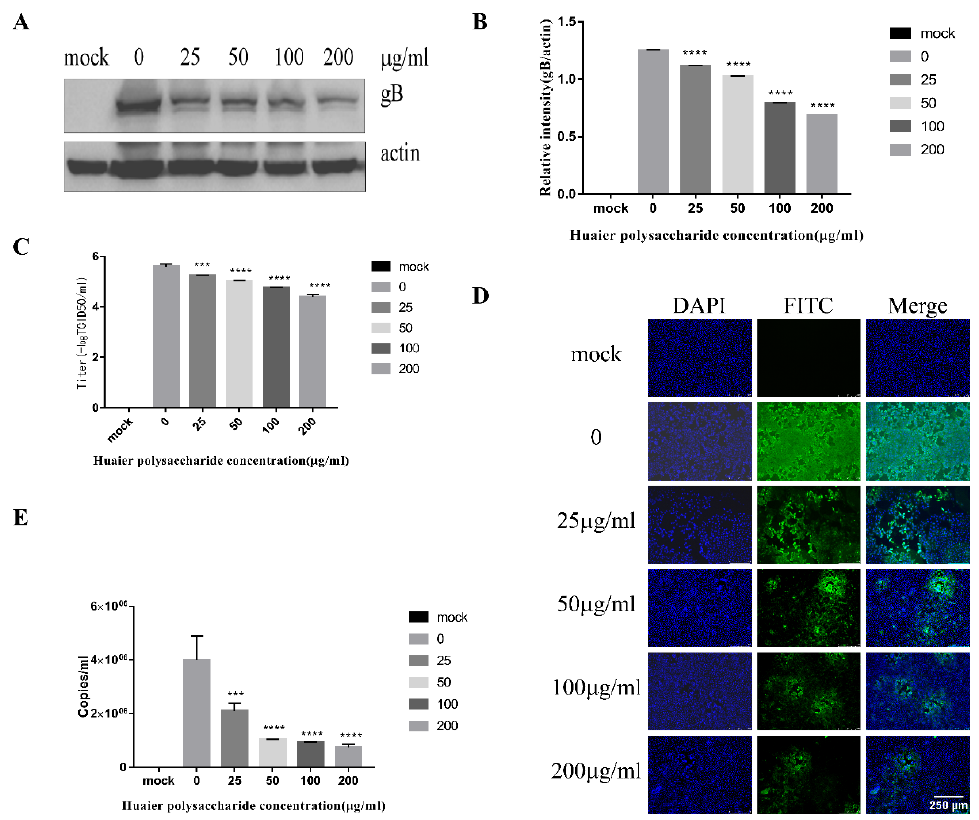
Figure 5. Huaier polysaccharide influences entry of pseudorabies virus in PK15 cells. The PK15 cells were treated according to the method described in Section 2.3.5. ( A ) At 24 h.p.i, PRV gB and actin protein expression were quantified through Western blot assay. ( B ) The relative intensity of intracellular gB to that of actin. Data are presented as the mean value from three independent statistical experiments. The relative intensities of protein were quantified using Image J. Significance was analyzed using the one-tailed Student’s t -test. ( C ) The viral titers were evaluated through TCID 50 assay. ( D ) Immunofluorescence assay (IFA) for internalized virus was performed. ( E ) Intracellular viral DNA copies were analyzed by qRT-PCR after cells were washed with citric acid and PBS to remove uninternalized virus. *** p = 0.0001, **** p < 0.0001. Data are shown as mean ± SD based on three independent experiments.